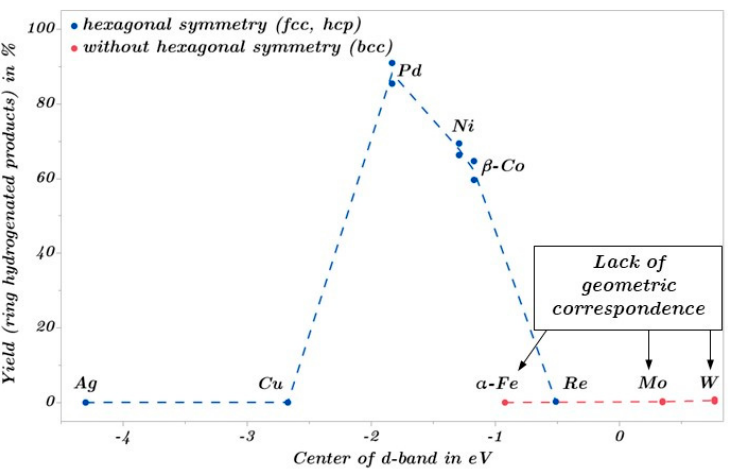
Figure 18. Dependence of the yield of ring hydrogenated products at 250 °C on the center of the d-band (Hammer and Norskov) and the lattice type of the metal used [33,34]. The dashed smoothing is based on a spline with λ = 0.05.